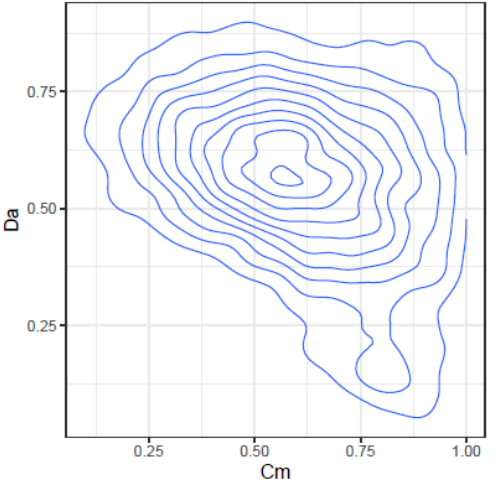
Figure 5. Joint density of C m and D A .